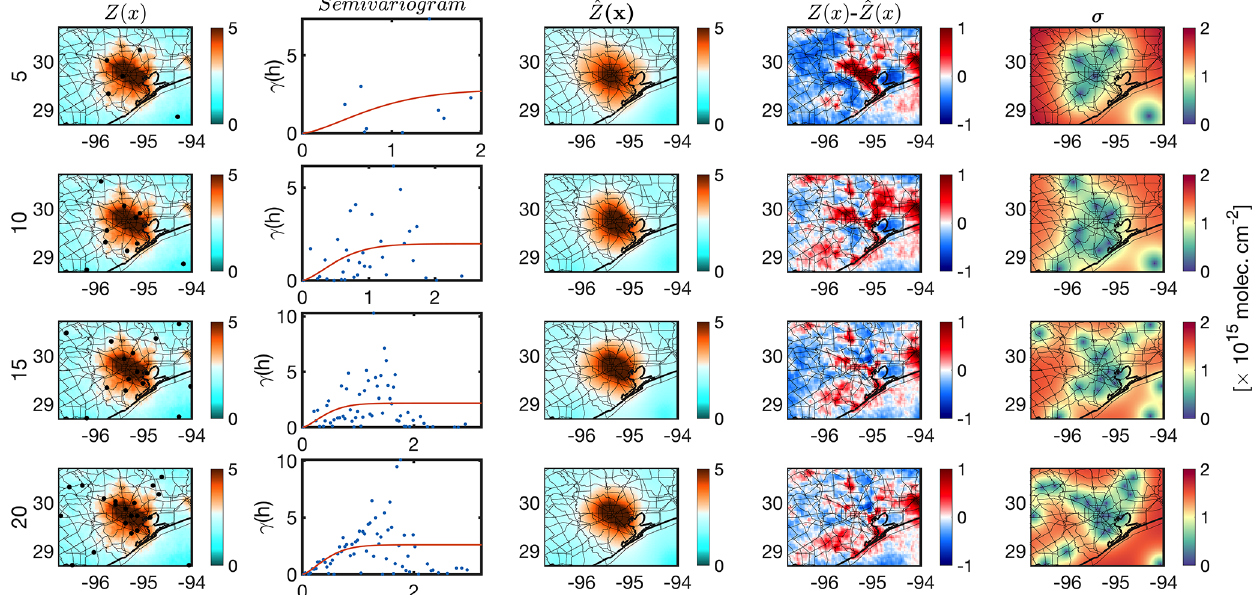
Figure 11. Finding an optimum sample tessellation for wintertime over Houston given a different number of spectrometers (5, 10, 15, and